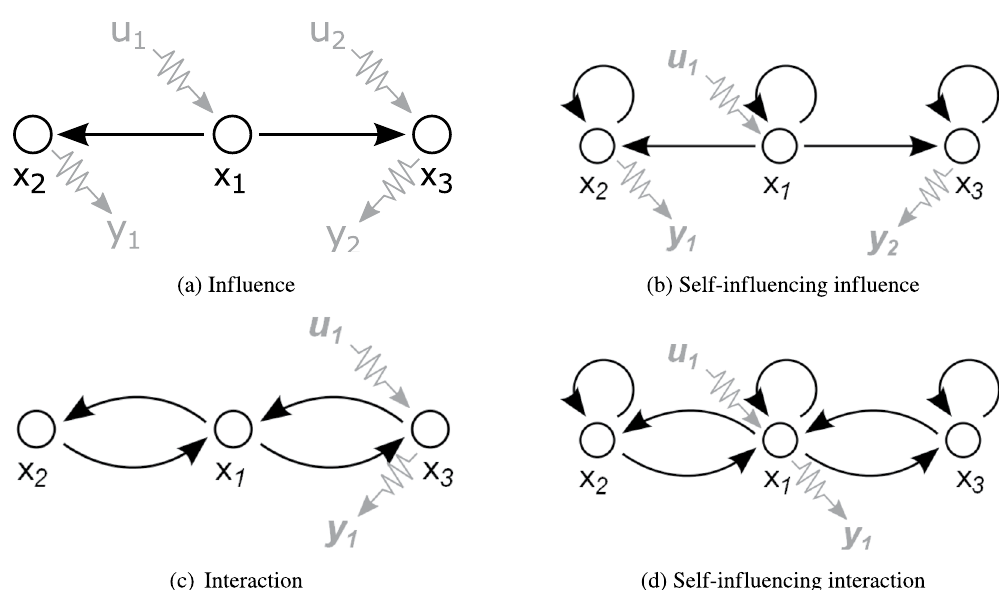
Figure 5. Physical representation and state-transition matrix-based representation of water tanks. The difference between the physical structure and the structure of the properly modelled state-transition matrix is significant.